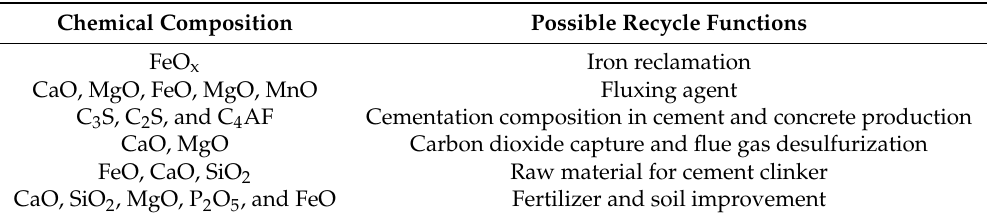
Table 4. Chemical composition in the EAF slag and possible recycle functions. Chemical Composition Possible Recycle Functions